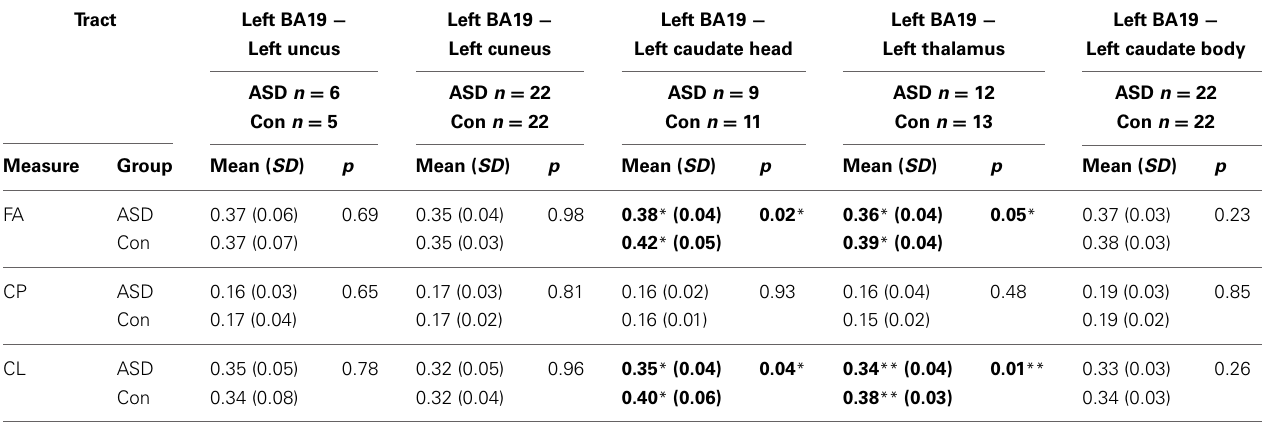
Table 4 | The mean, standard deviation and p -values for the three micro-structural dependent measures (FA, CP, CL) for white matter tracts connecting functionally defined regions in the ASD and control groups.